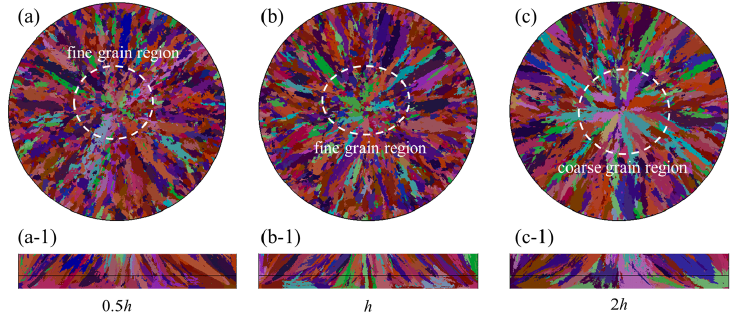
Figure 15. Simulated solidification structure under di ff erent heat transfer coe ffi cient, where ( a – c ) are the cross-section structure of billet, ( a-1 – c-1 ) present the longitudinal section structure of billet; the heat transfer conditions are 0.5 h ( a , a-1 ), h ( b , b-1 ), and 2 h ( c , c-1 ),